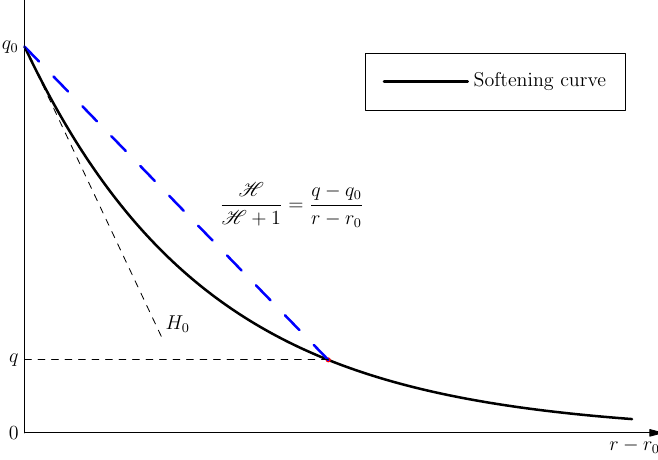
Figure 2. Definition of the continuum softening parameters H and H